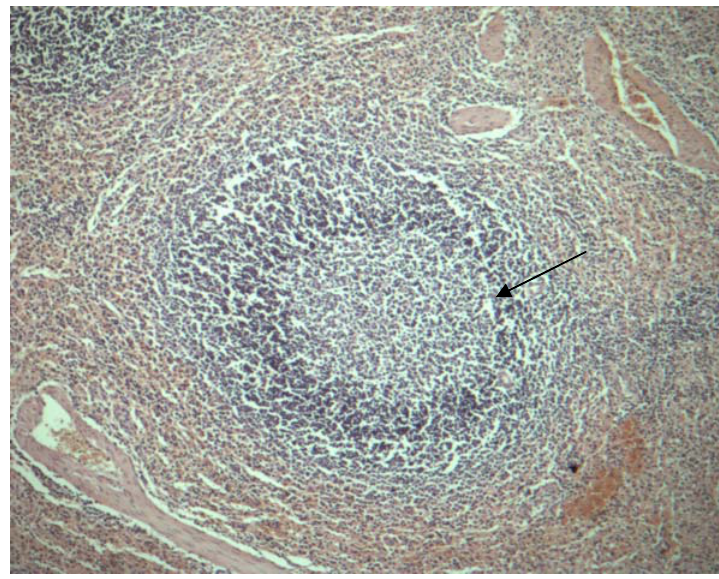
Figure 8. Microscopic aspect of the spleen from a dog inoculated with crotalic venom, showing hyperplasia of the lymphoid tissue in the white pulp, evidenced by the expanded germinative center of the lymphoid nodule (arrow) (HE, 100X).